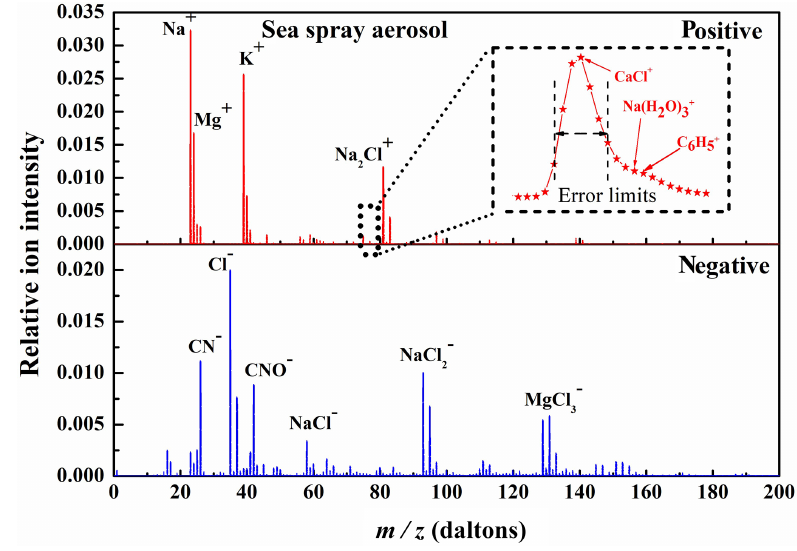
Figure 4. Averaged positive and negative mass spectra of sea spray aerosols. Table 2. Peak identification of important chemical species in sea spray aerosols. The first column is the measured m/z for peaks. The second and third columns show the theoretical m/z bin value and theoretical m/z value of most possible species for each peak. Measurement Possible species Possible species Measurement Possible species Possible species m/z (positive) (theoretical m/z (theoretical m/z m/z (negative) (theoretical m/z (theoretical m/z bin value) value) bin value)